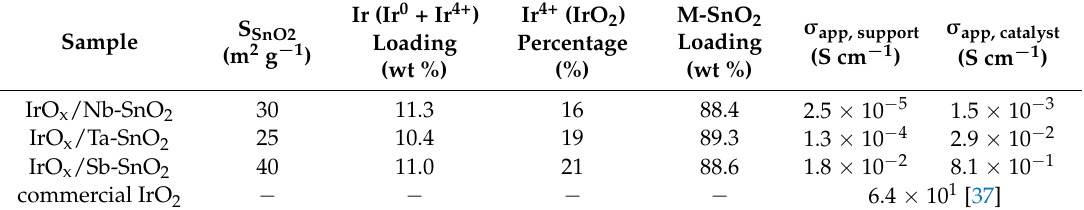
Table 1. BET surface areas for the supports (S SnO2 ), Ir loadings (Ir 0 + Ir 4+ ), IrO 2 percentages (corresponding to Ir 4+ vs. total Ir) in IrO x nanoparticles, M-SnO 2 loadings, and apparent electrical conductivities of M-SnO 2 supports (σ app, support ) and IrO x /M-SnO 2 catalysts (σ app, catalyst ).